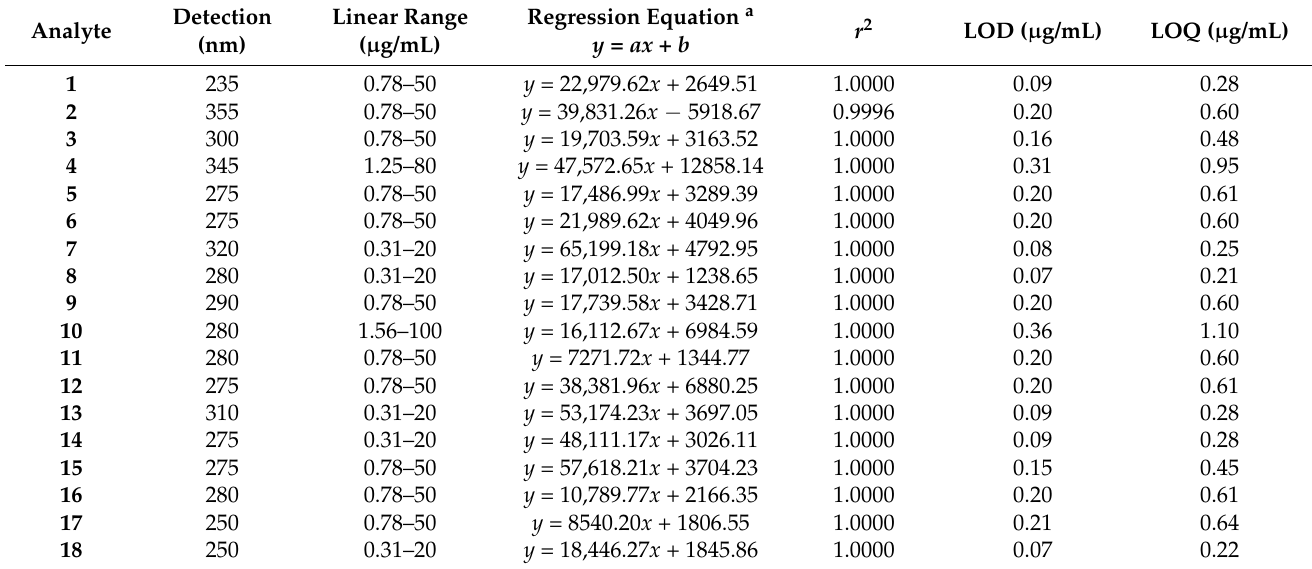
Table 1. Linear range, regression equation, r 2 , limit of detection (LOD), and limit of quantification (LOQ) values for HPLC analysis of compounds 1 – 18 ( n = 3).